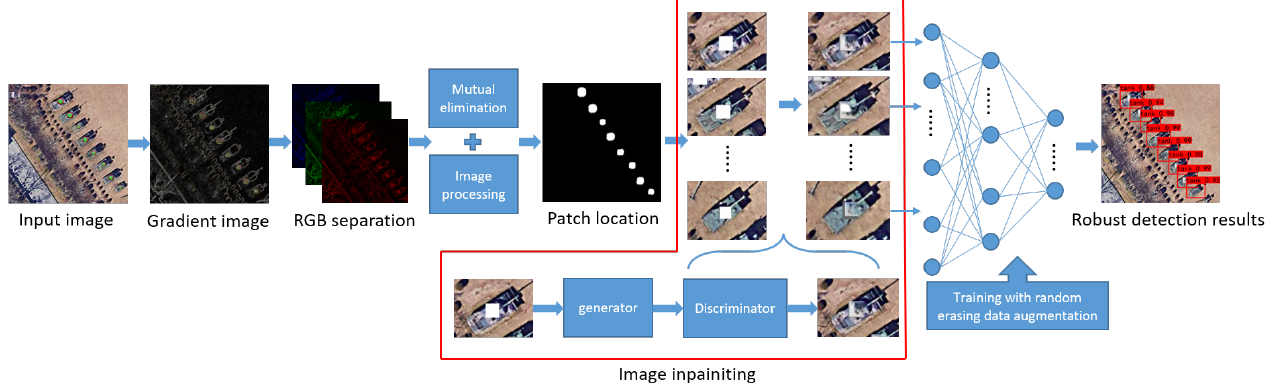
Figure 1. Conceptual illustration of our method. We use the localization algorithm to locate the adversarial patch and remove the located adversarial patch and then use image inpainting technology to inpaint the removed area. We propose using the random erasing data augmentation algorithm to expand the training dataset to enhance the weak occlusion robustness of the model. Through the above framework, the detection robustness of the model will be greatly